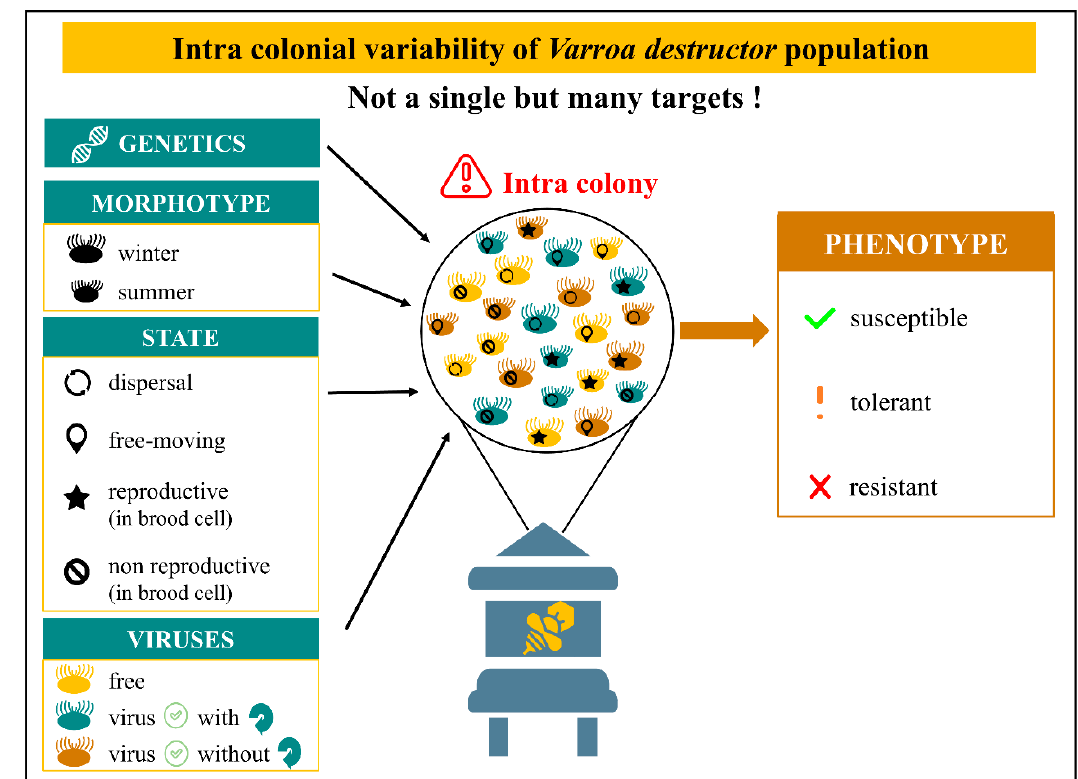
Figure 2. Intra colonial variability of V. destructor population. Genetics through several traits can influence the phenotype [168]. Mites differ from winter to summer with a dynamic morphotype ratio going from 20% of winter morphotype in summer to 20% of summer morphotype in winter [173,174]. In addition, V. destructor can be divided in four different states: dispersal ecto-parasite attached to honeybee’s body, comb mite freely moving inside the hive, reproductive acari confined in brood cell and non-reproductive mite confined in brood cell [30,172]. Virus loads add a third dimension where the mite can be free of viruses, virus-positive with replication or virus-positive without replication (asymptomatic). This combination of different states, morphotypes and virus loads produce a variety of acari which represents distinct targets with their own reachability.